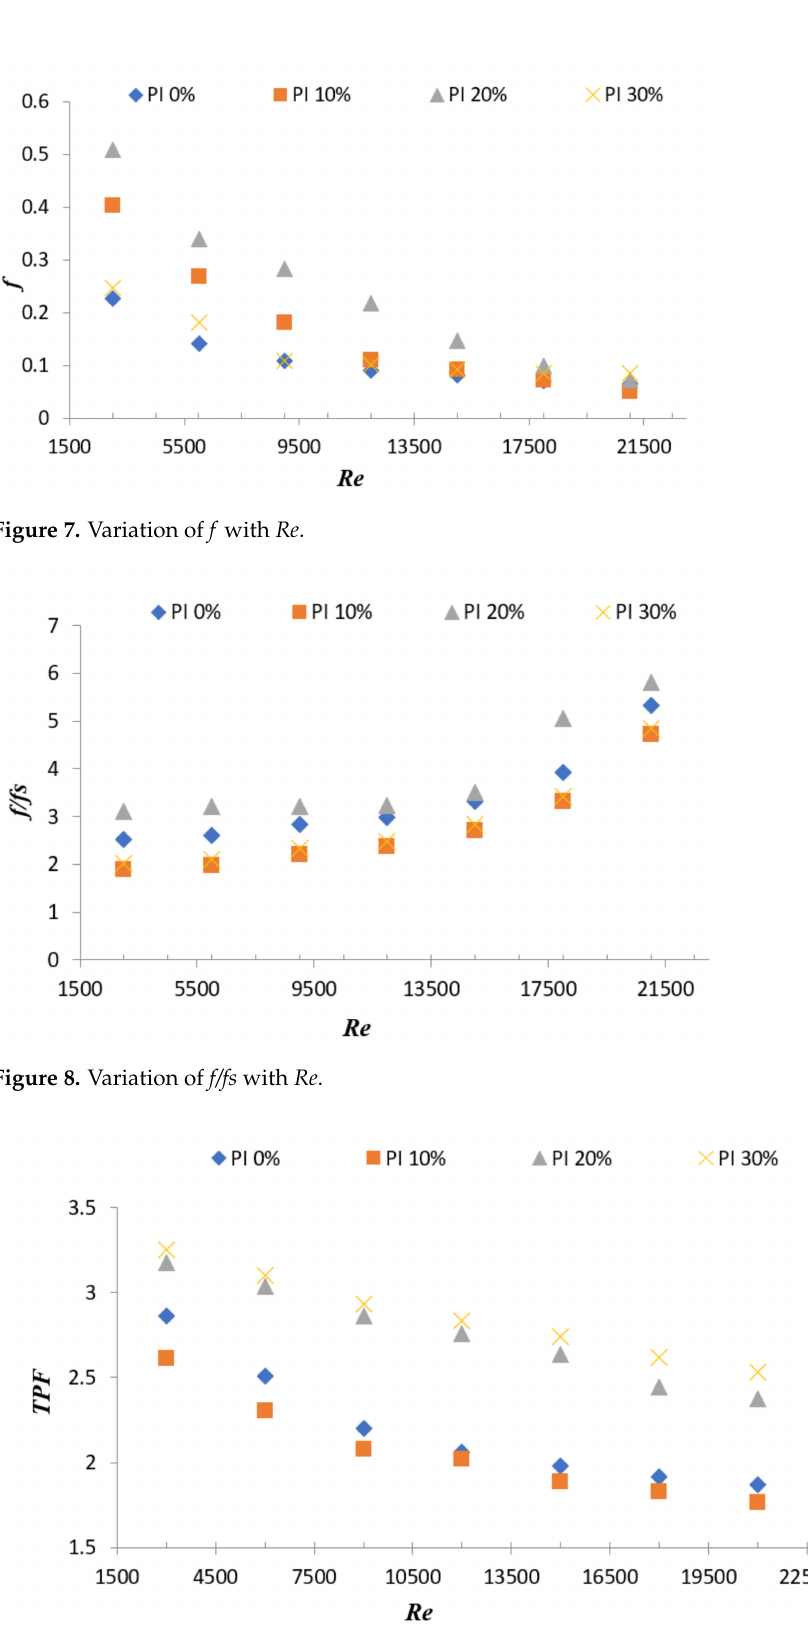
Figure 9. Variation of TPF with Re